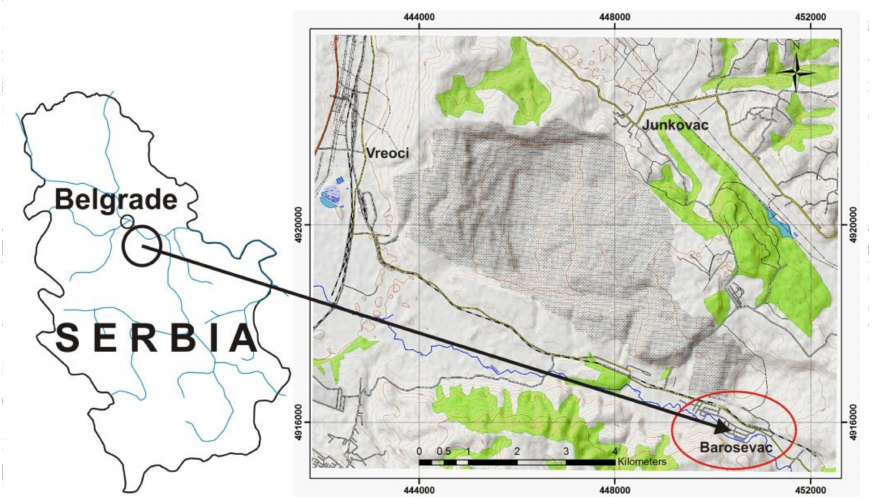
Figure 1. Geographic location of